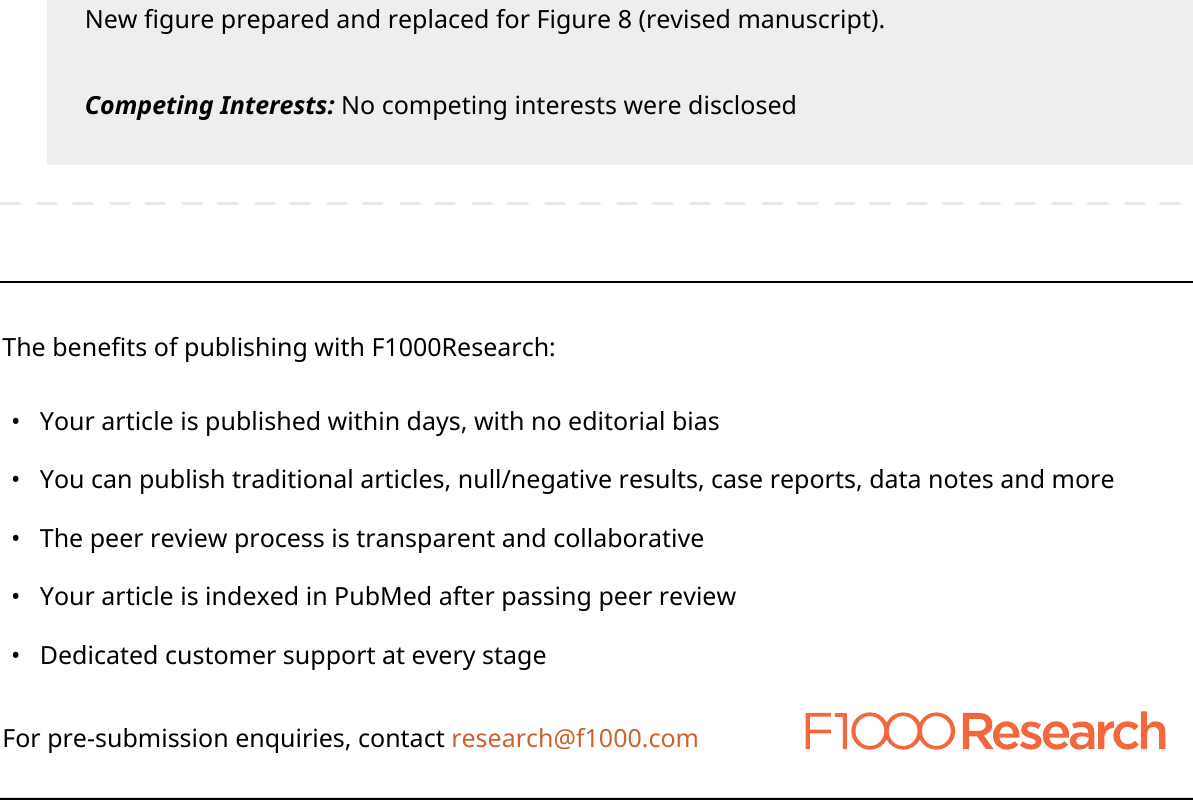
Figure 8: A simpler scatter plot will be more informative rather than overlapping 3D plots in the current version of the manuscript. Also, information on the testing pressure should be included in the